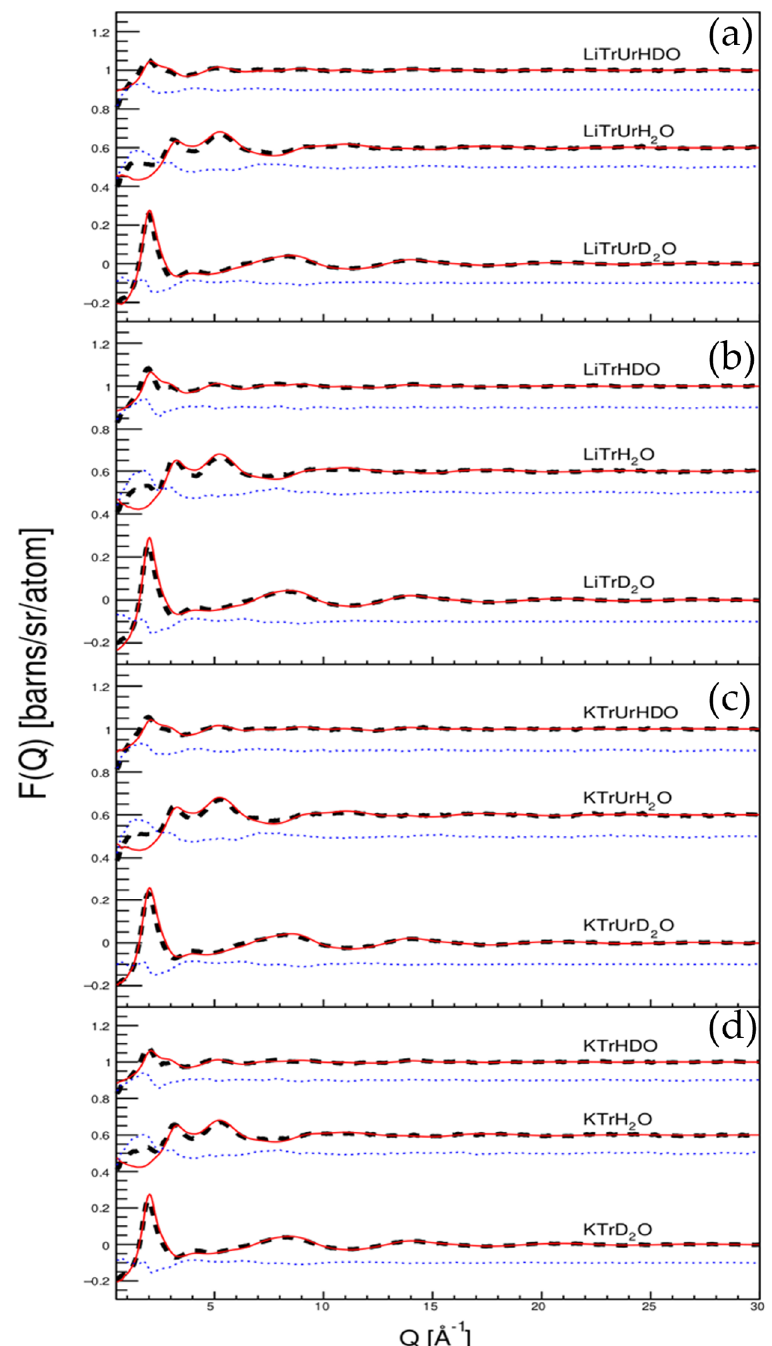
Figure 2. Experimental neutron total scattering profiles (dashed black lines), the EPSR fitted neutron structure factors (red lines) and their differences (blue dots). ( a ) Trehalose in LiOH/urea aqueous solution, ( b ) trehalose in LiOH aqueous solution, ( c ) trehalose in KOH/urea aqueous solution, ( d ) trehalose in KOH aqueous solution. Data have been offset for clarity. EPSR gave us the most probable, all-atom structures in trehalose alkali/urea